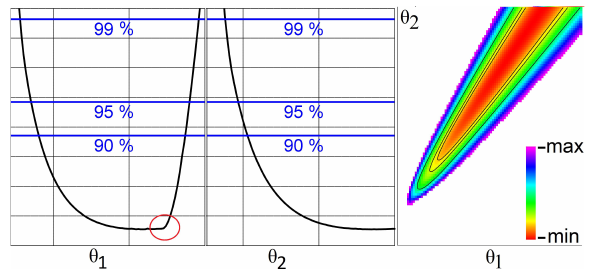
Figure 3: The log-likelihood profile of two inter- dependent parameters is plotted in the plane of both parameters (right panel), with corres- ponding projections to each of the two para-